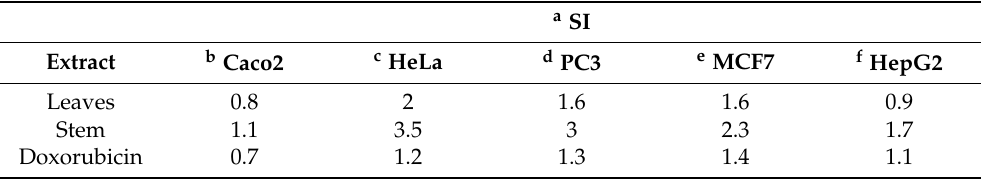
Table 5. Selectivity index values of Calystegia silvatica methanol extract from leaves and stems for Caco2, HeLa, PC3, MCF7 and HepG2 cancer cell lines.